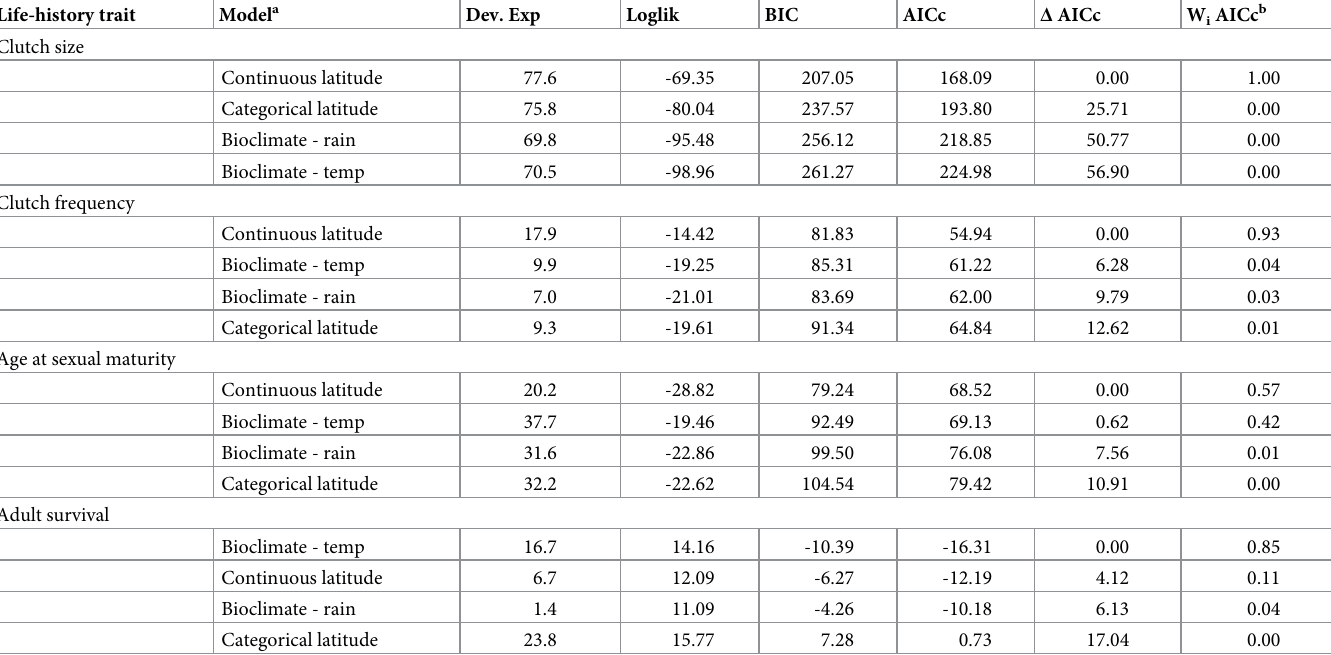
Table 3. Freshwater turtle life-history model comparisons. Comparisons of the Generalized Additive Models created for each life-history trait to estimate capacity for sustainable harvest in freshwater turtles. Models for each trait ordered by decreasing AICc (Akaike information criterion corrected for small sample sizes) values. Life-history